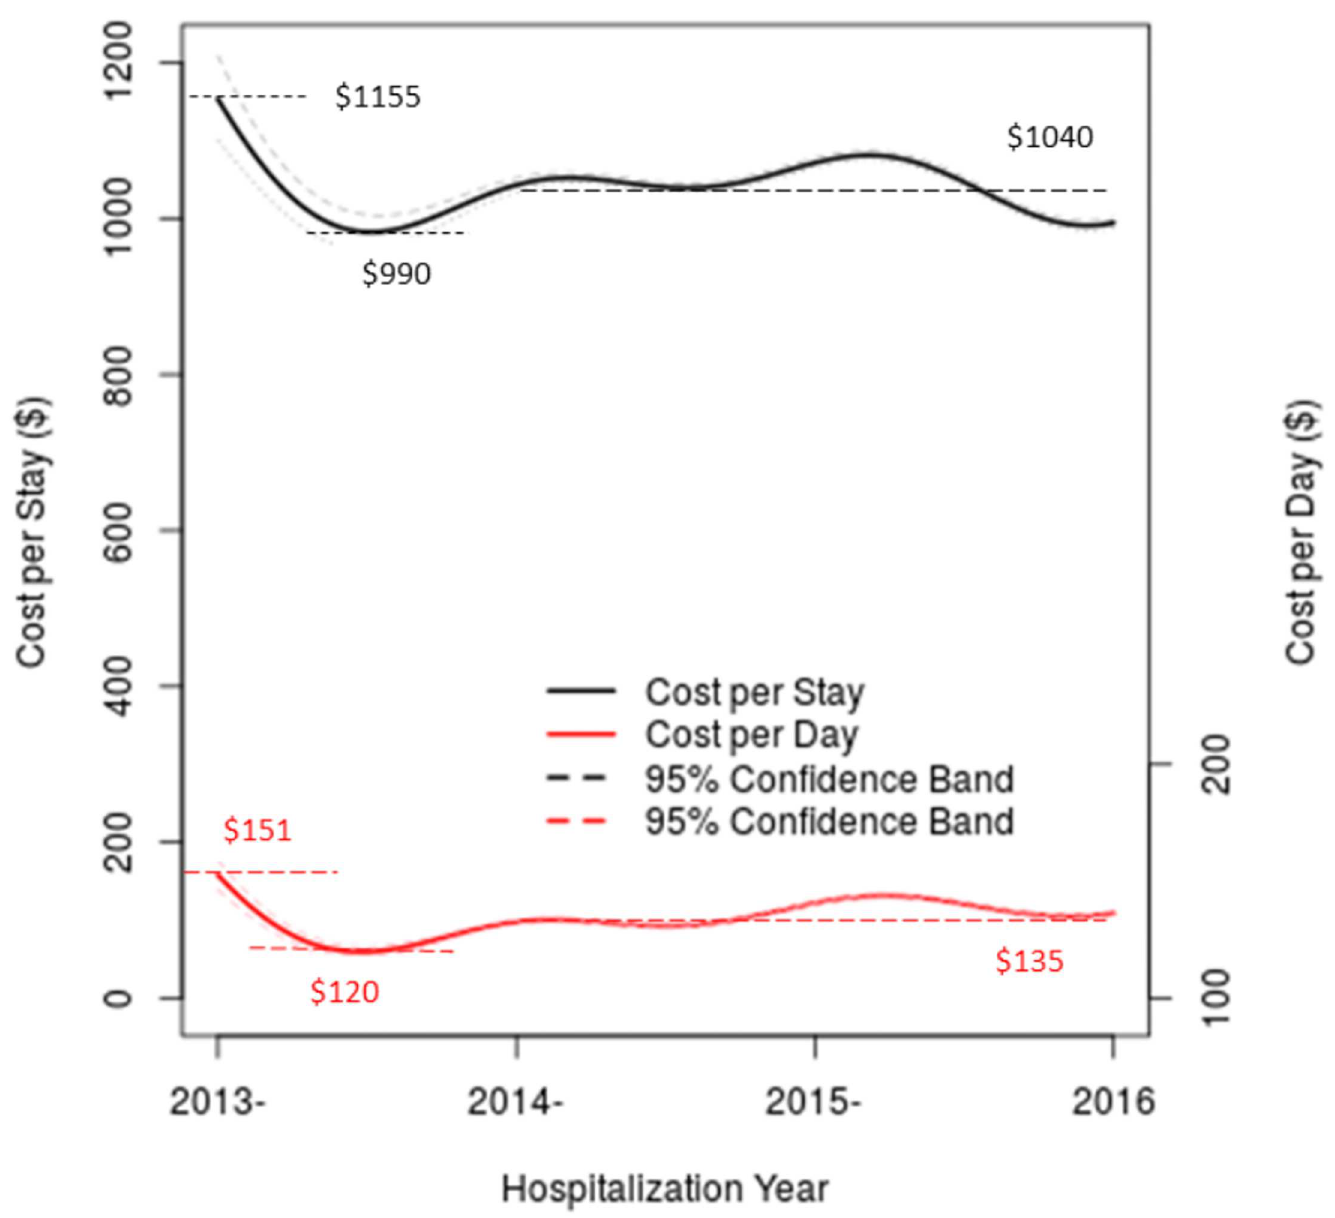
Fig 1. Temporal trends of cost per stay indicated by the left y-axis (from $0 to $1,200),and temporal trends of cost per day indicated by the right y-axis (from $50 to $250).